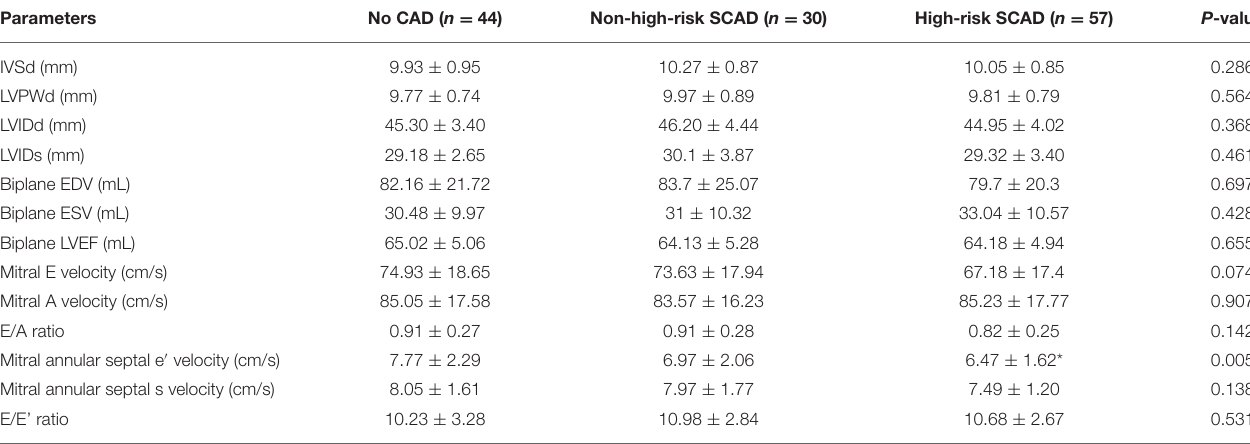
TABLE 3 | Global and regional myocardial work parameters among the three groups. Parameters